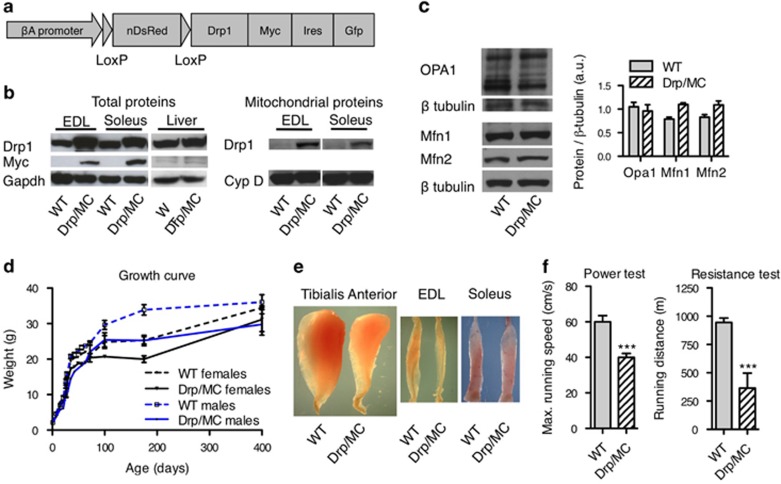
Mice overexpressing Drp1 (Drp/MC) in muscle have a severe reduction of muscle mass. (a) Transgene construct. (b) Left: Drp1 and Myc proteins were analysed by western blot in EDL and soleus muscles and liver of WT and transgenic animals, right: Drp1 expression in mitochondrial extract was analysed by western blot. Cyclophilin D (CypD) is used as a loading control. (c) Mitofusin 1 (Mfn1), Mitofusin 2 (Mfn2) and Opa1 expression was analysed by western blot. Quantification is given in the right chart (n=4 animals per genotype). (d) Growth curve of WT and Drp/MC animals (n=5 animals per group). (e) Pictures of WT and Drp/MC Tibialis anterior (TA), EDL and soleus muscles. (f) Speed and distance performed by P200 WT and transgenic mice on treadmill tests evaluating power and resistance (n=7 animals per genotype). Error bars represent S.E.M. ***P<0.001 versus wt